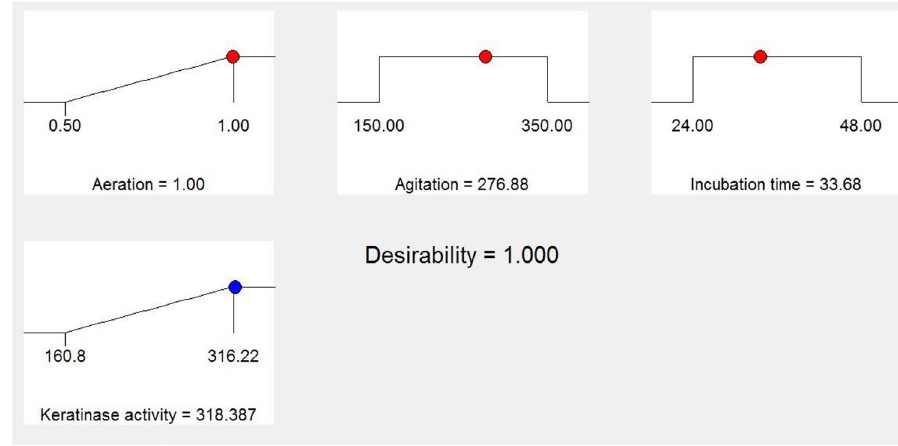
Fig. 3 Desirability ramp for numerical optimization of three independent